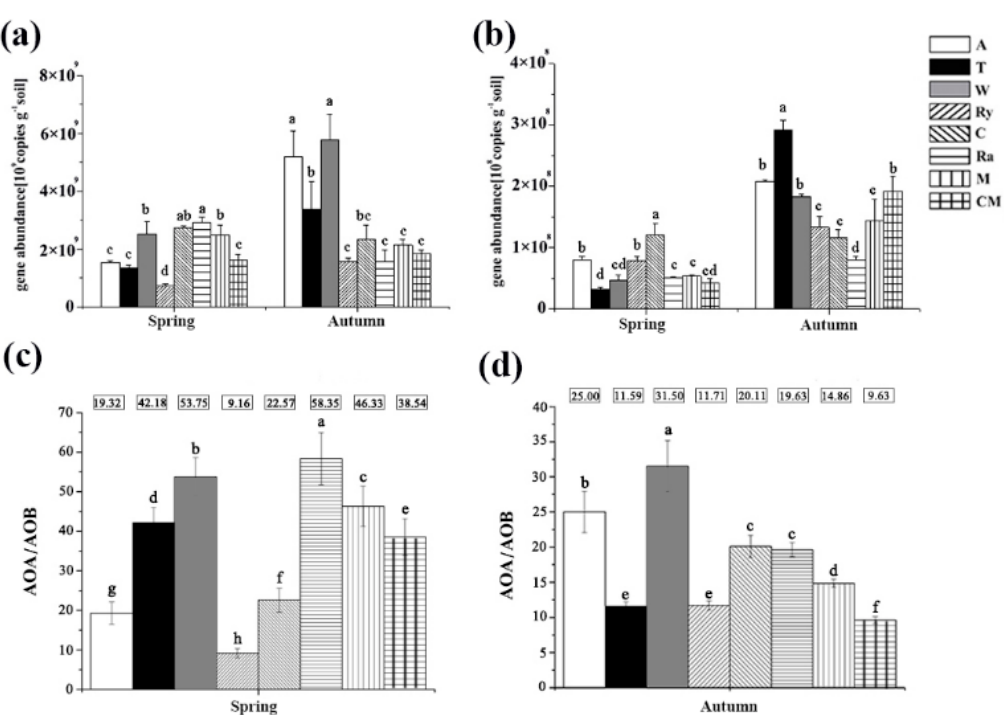
Figure 3. The abundances of soil ammonia-oxidizing archaea (AOA) ( a ), ammonia-oxidizing bacteria (AOB) ( b ), and ratio AOA/AOB during spring ( c ) and autumn ( d ) in different treatments. A—alfalfa; T—trifolium; W—wheat; Ry—rye; C—chrysanthemum; Ra—rape; M—mustard; CM—cucumber monoculture. Columns with different letters are significantly different at 0.05 probability level. Table 2. Pearson correlation coefficients between soil properties and AOA and AOB